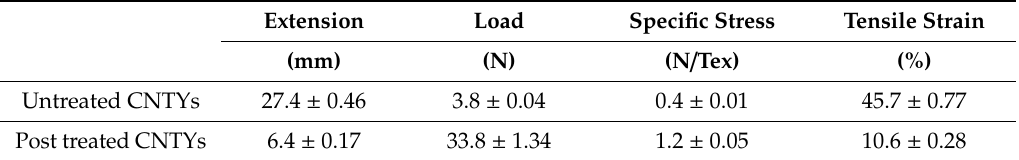
Figure 1. Stress–strain curve of untreated CNTY ( A ) and post-treated CNTY ( B ). Table 1. Mechanical properties of carbon nanotube yarns (CNTYs) during single axial